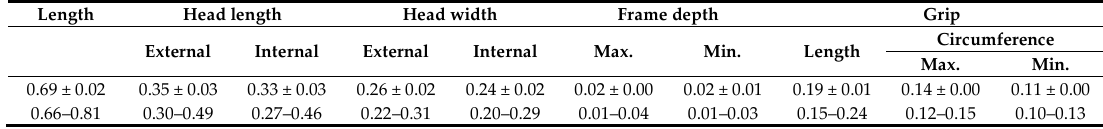
Table 2. Geometric properties in meters. Mean ± Standard Deviation, Range.